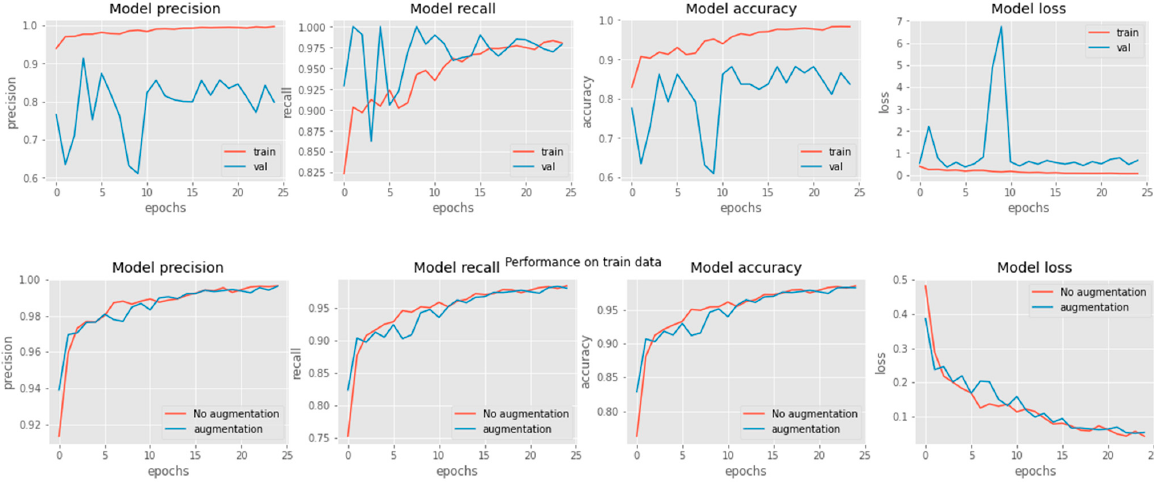
Figure 10. Comparisons graph for proposed model accuracy compared with loss related to data augmentations and no